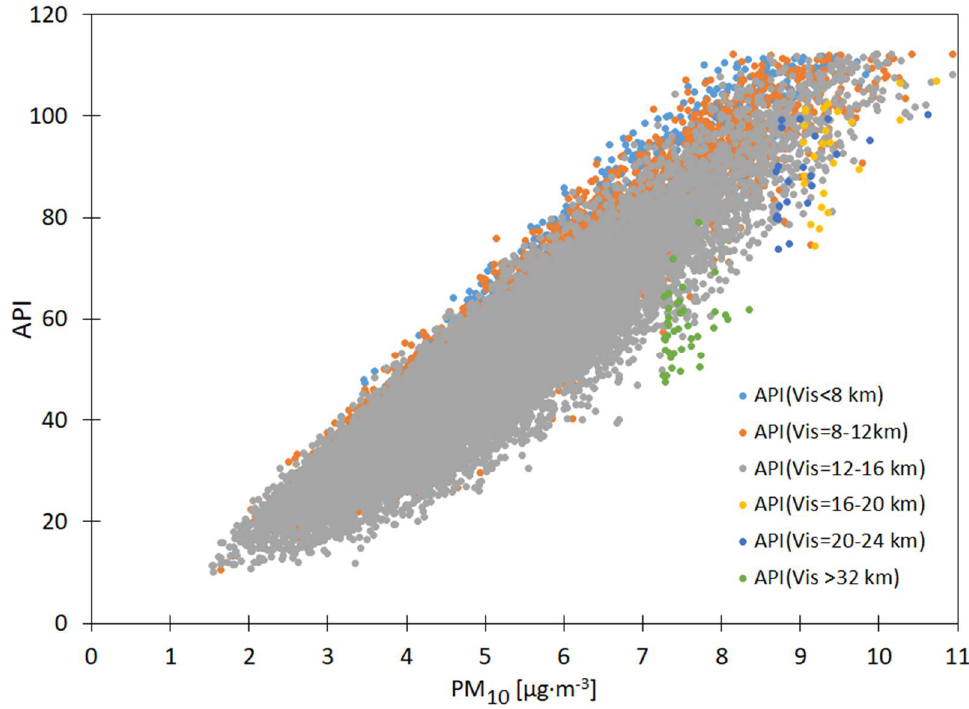
Figure A9. Effect of visibility-dependent PM 10 air concentrations on the air pollution index for the springtime rain-free period.